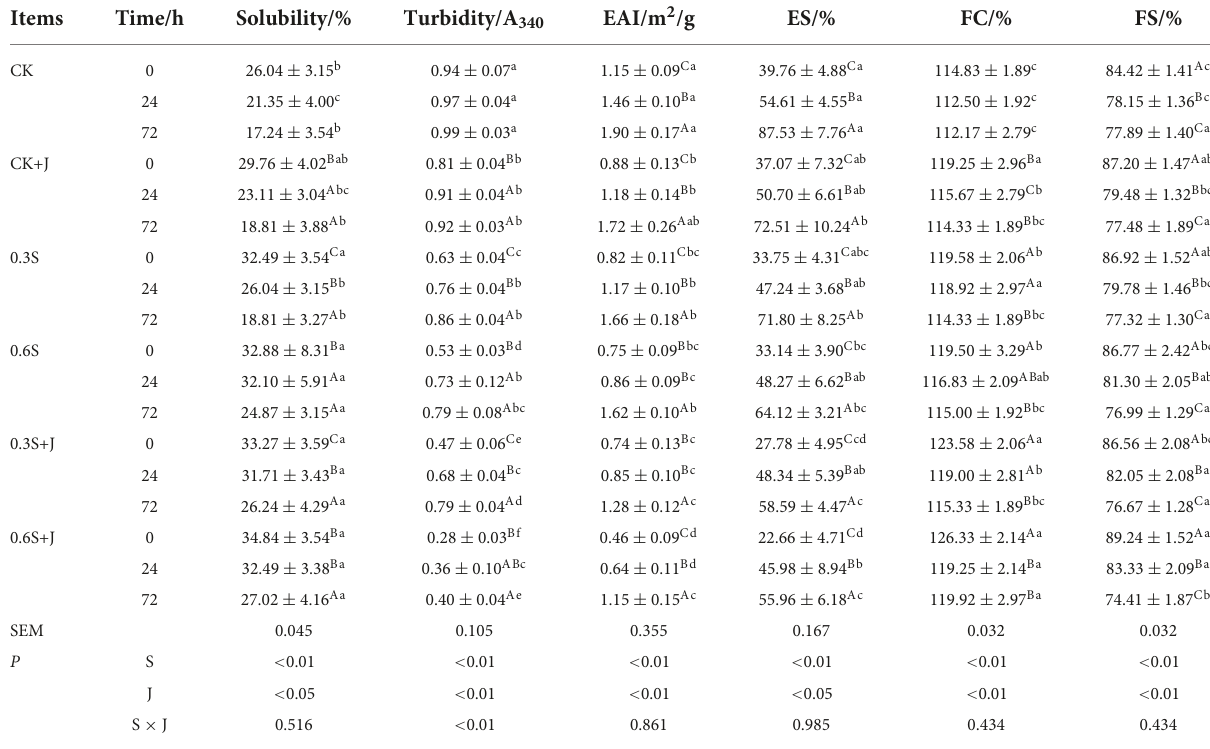
TABLE 5 Changes on functional properties of post-mortem chicken myofibrillar protein from selenium yeast and jujube powder dietary supplements.